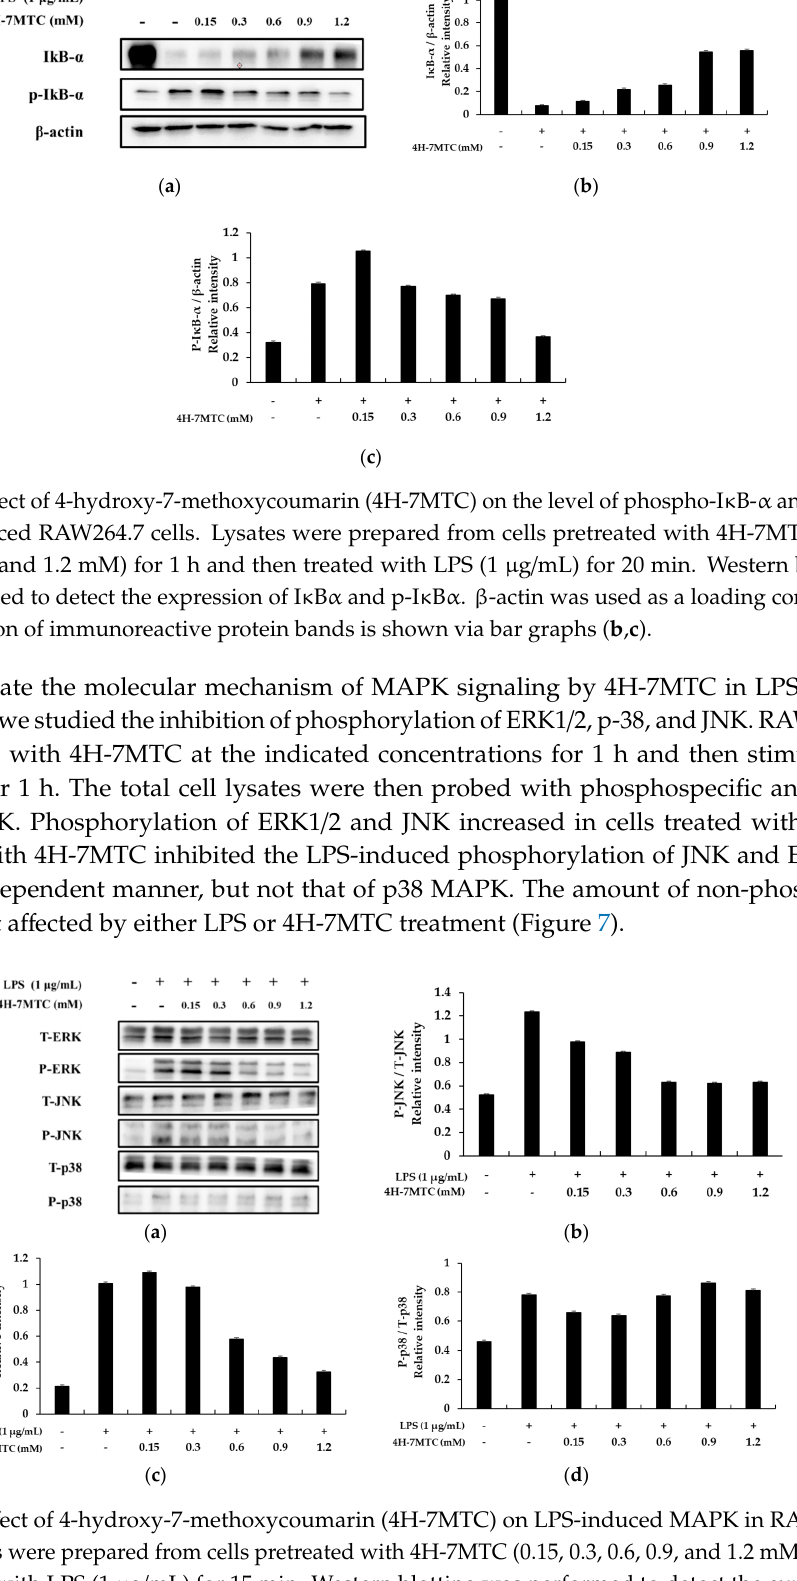
Figure 7. Effect of 4-hydroxy-7-methoxycoumarin (4H-7MTC) on LPS-induced MAPK in RAW264.7 cells. Lysates were prepared from cells pretreated with 4H-7MTC (0.15, 0.3, 0.6, 0.9, and 1.2 mM) for 1 h and treated with LPS (1 μ g/mL) for 15 min. Western blotting was performed to detect the expression of phospho-ERK, T-ERK, phospho-JNK, T-JKN, phospho-p38, and T-p38 ( a ). β -actin was used as a loading control. Quantification of immunoreactive protein bands is shown via bar graphs ( b – d